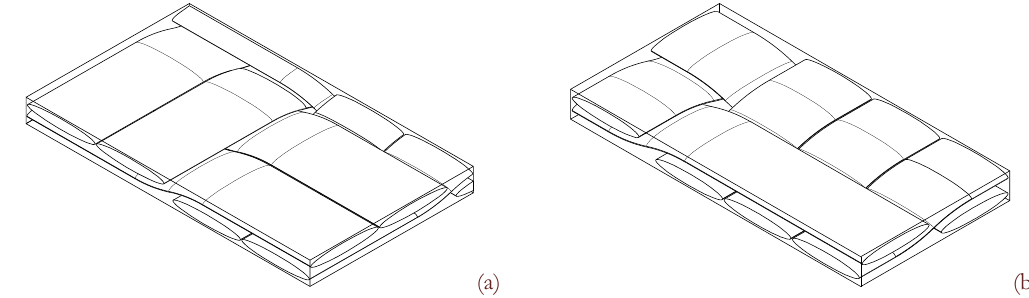
Figure 5: 3D models of the RVE. (a) Twill weave 2/2; (b) Twill weave 1/3.